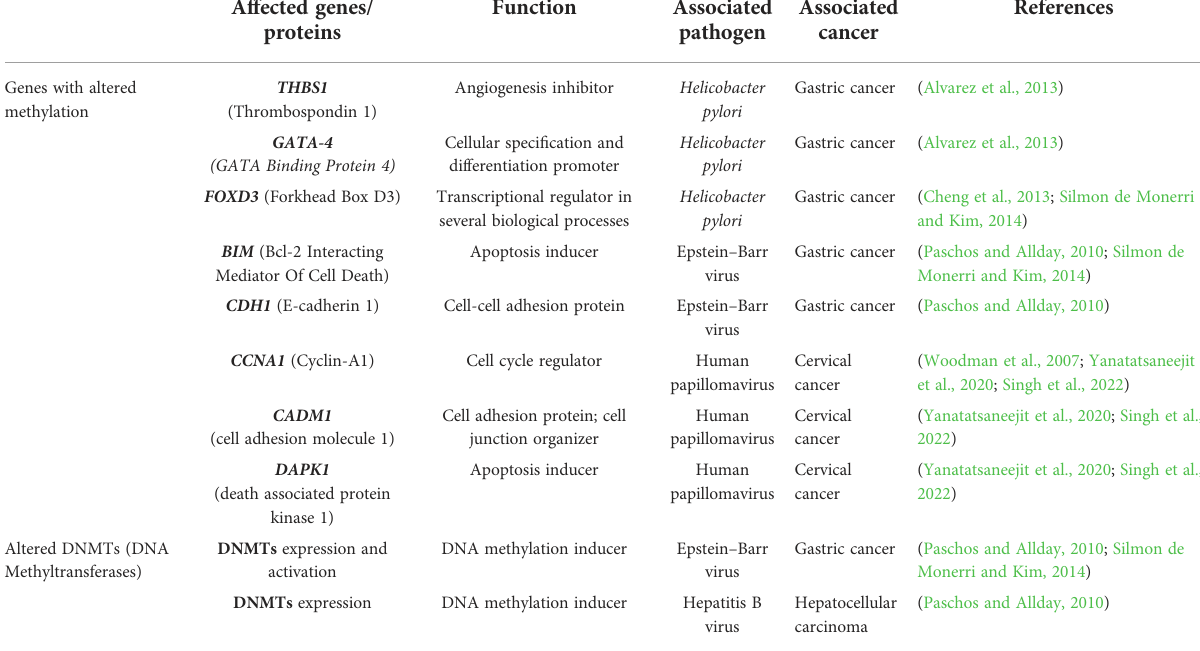
TABLE 1 DNA methylation-related alterations in pathogen infection-associated cancer.